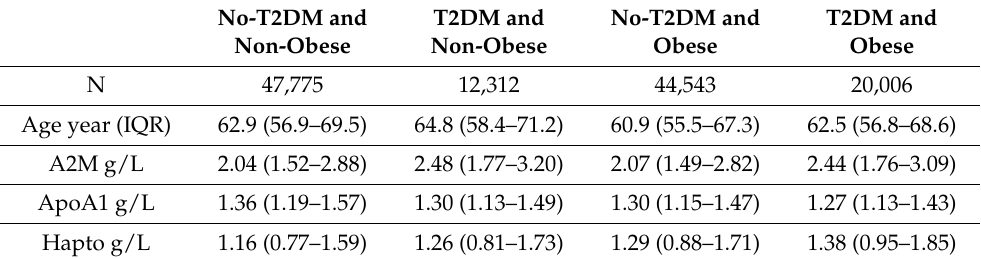
Table 5. Characteristics and median protein levels in men ≥ 50 years of age according to T2DM and obese